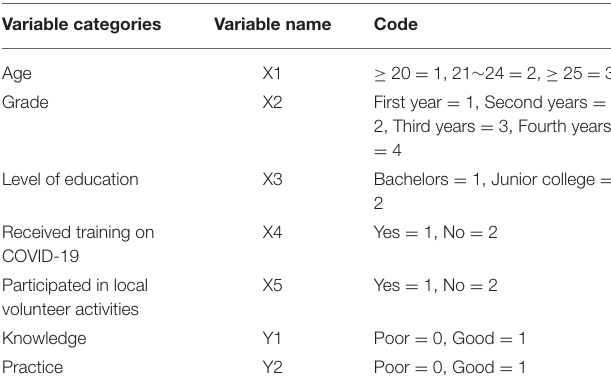
TABLE 3 | Variable definition for factors associated with good knowledge, attitude, and practice. Variable